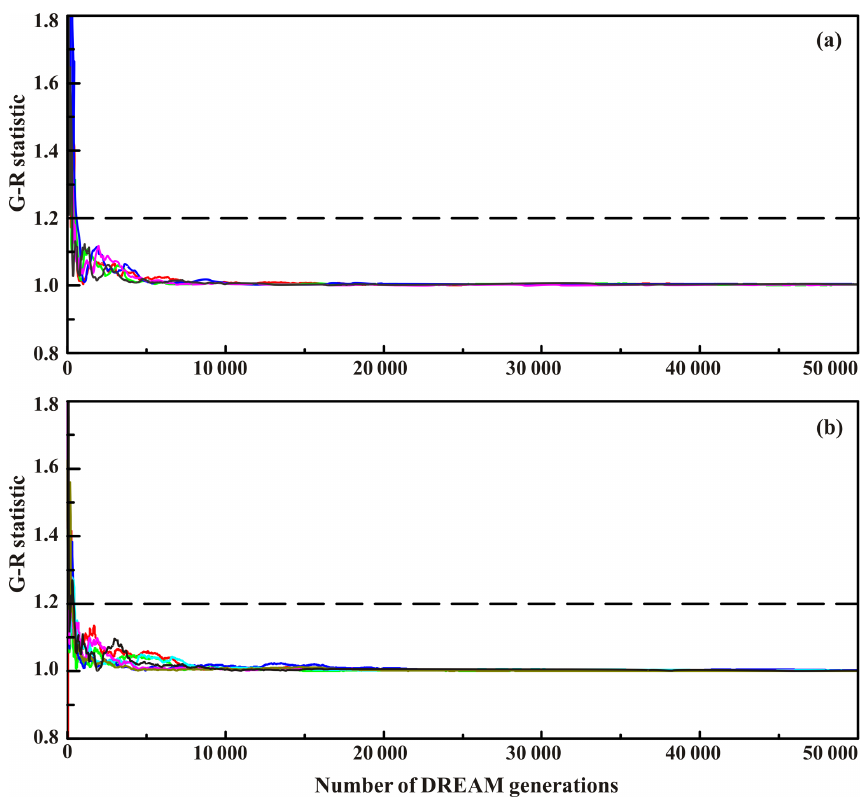
Figure 1. Trace plots of the G–R statistic using DREAM for the PM model (a) and (b) the SW model. Different parameters are coded with different colors. The dashed line denotes the default threshold used to diagnose convergence to a limiting distribution. Table 1. Prior distributions and parameter limits for the PM, SW, PT–FC and AA models. The values are derived from the literature. Parameter